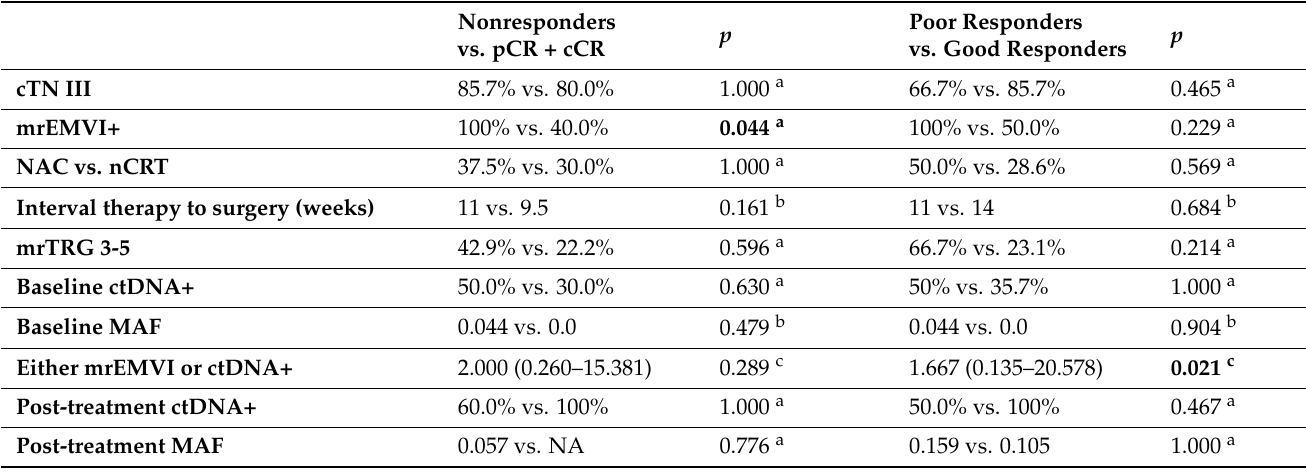
Table 2. Summary of the relationship between risk factors and main outcomes.